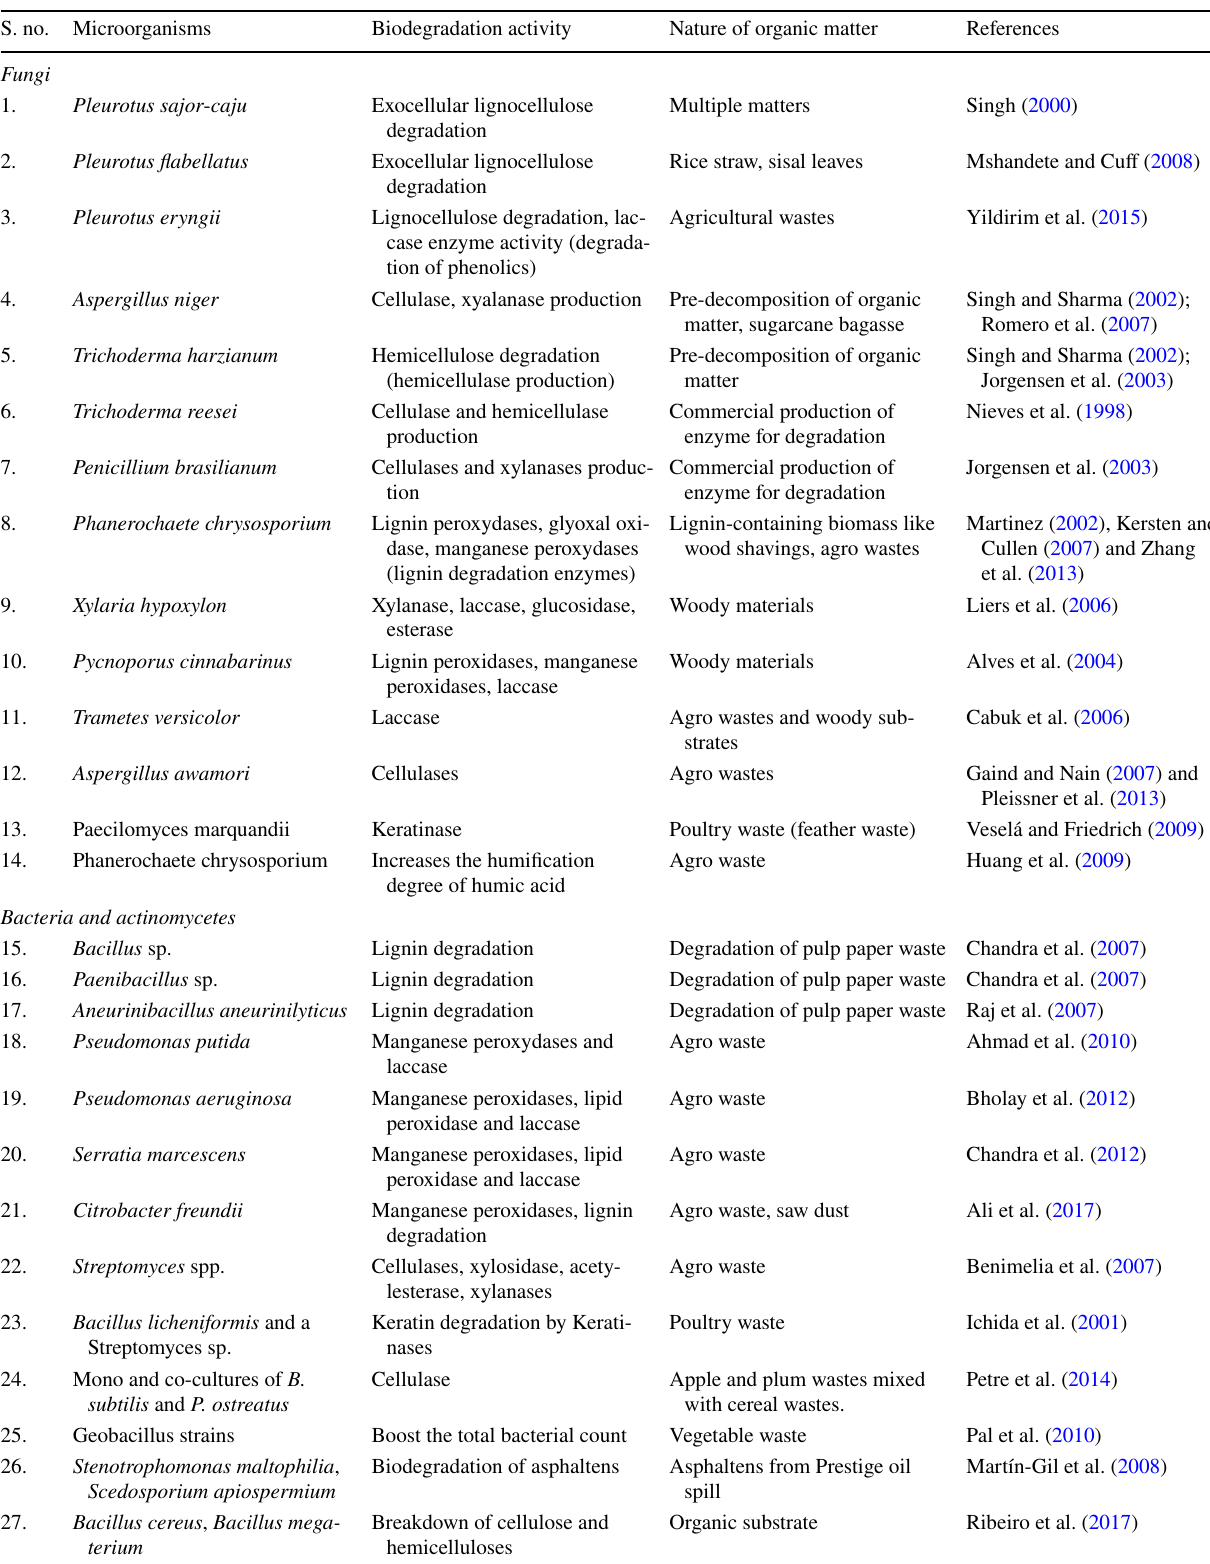
Table 1 Various bacteria and fungi have been isolated, identified, and their products, especially enzymes were used for enhanced decomposition and degradation of agricultural residues into